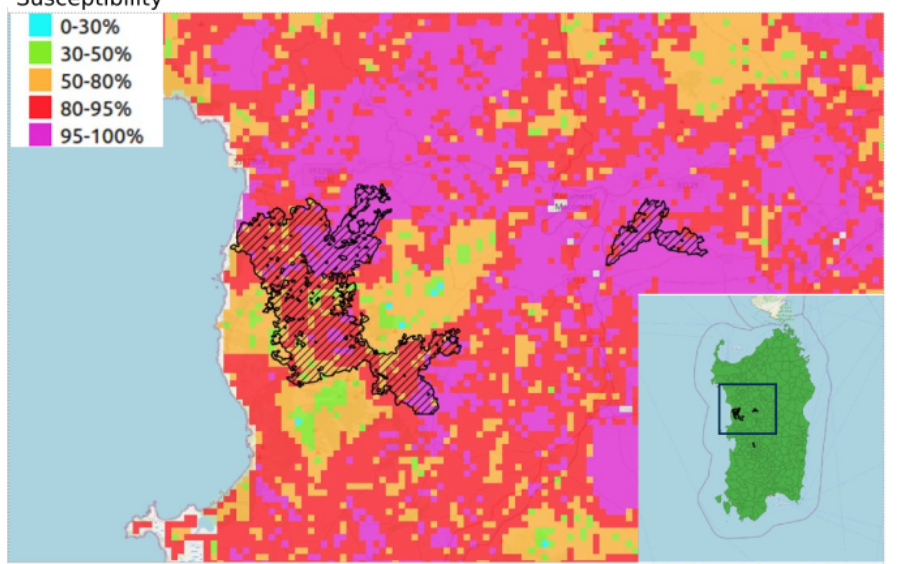
Figure 19. The North Western Sardinia island (see the bottom right box for the location of the examined wildfires in the island).The map portrays the spatial summer susceptibility produced by machine learning. The colors refer to the five classes of susceptibility (see Table 2). The satellite- retrieved burned scar of the Montiferru area wildfire (on the West, July 2021) and of Marghine (on the East, August 2021) are represented as hashed